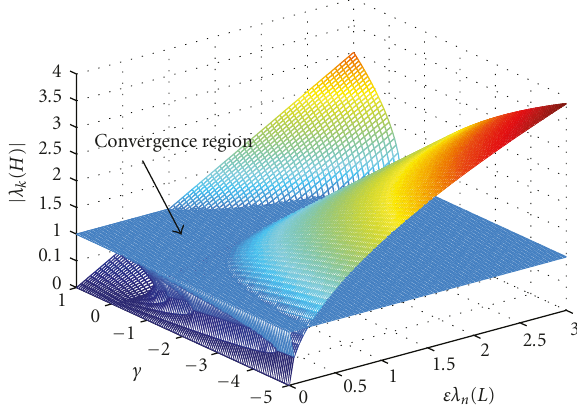
Figure 1: Convergence region for the SO-DCTS algorithm in undirected networks: three-dimensional